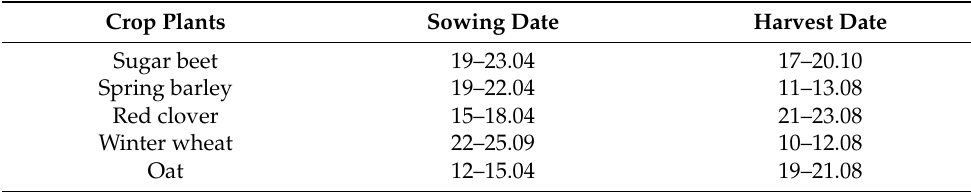
Table 3. Dates of sowing and harvesting of spring wheat forecrops.